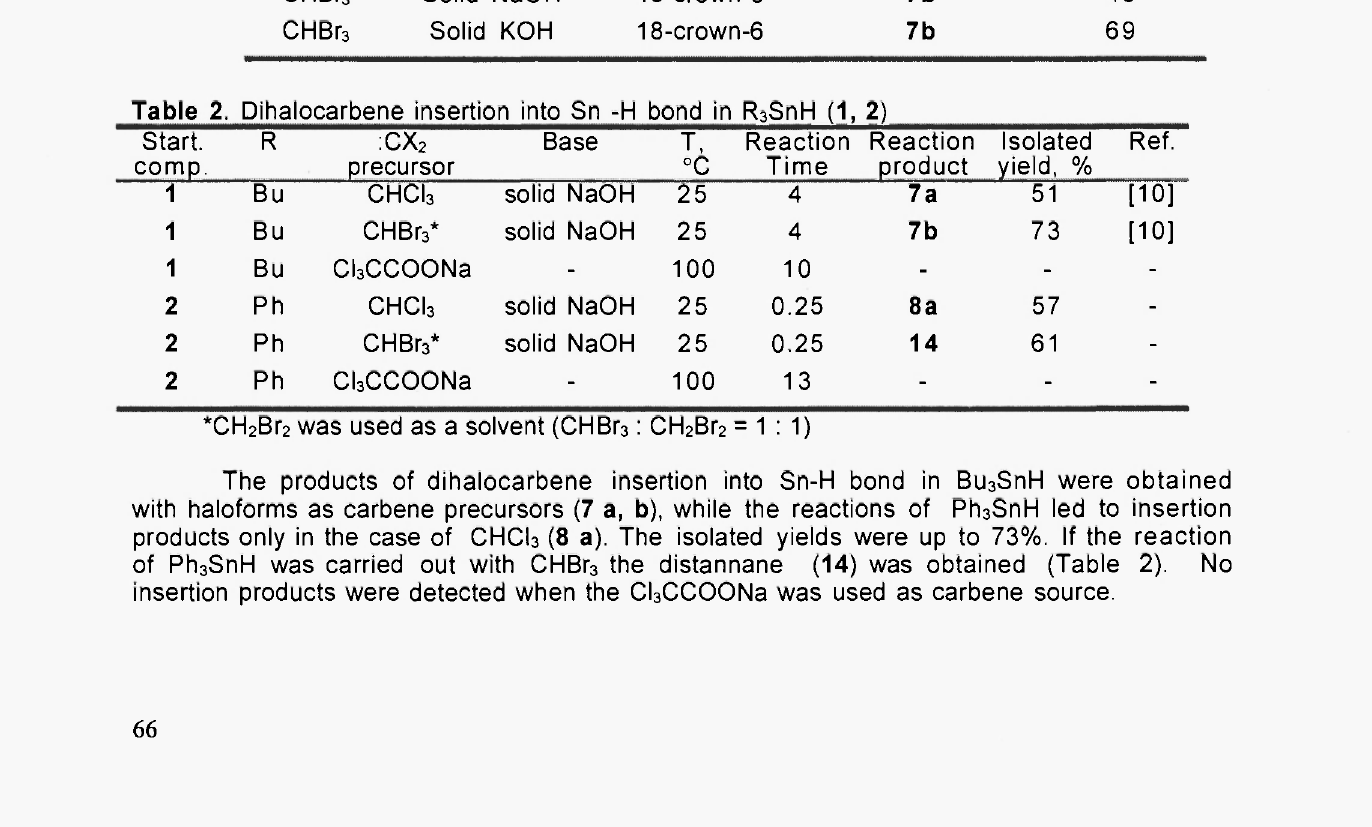
Table 2. Dihalocarbene insertion into Sn -H bond in R 3 SnH (1, 2)